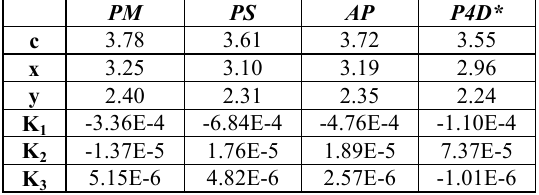
Table 2. Calibration results for the Phantom 3.